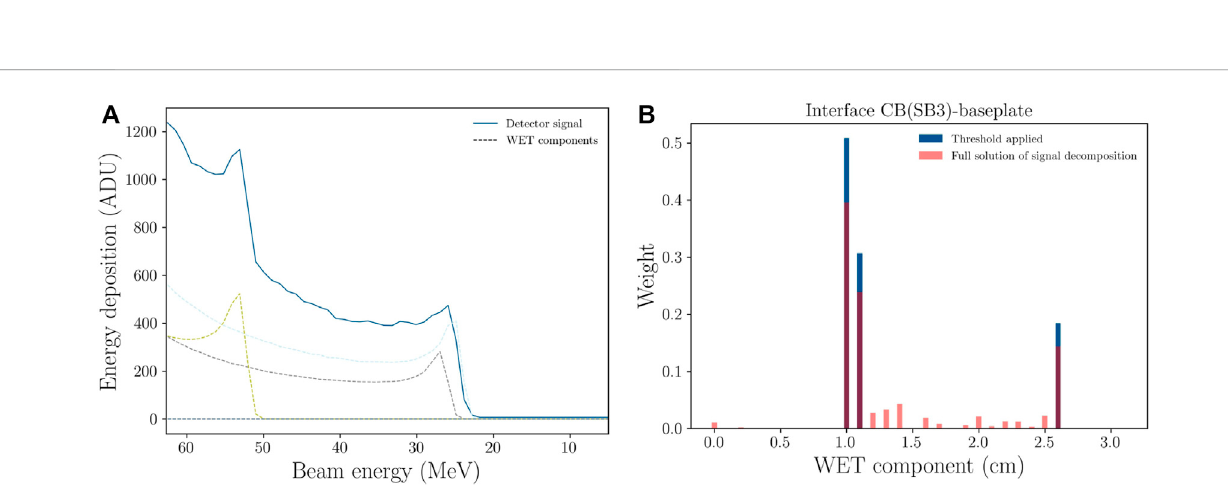
FIGURE 6 Example of the signal decomposition algorithm for a pixel in an interface region between the cortical bone (SB3) insert and the baseplate, leading to rangemixing. (A) Measureddetectorsignalinapixelwitharangemixing(solidline).TheWETcomponentsobtained via Braggpeakdecomposition(Figure6B) are indicated as dashed lines. (B) WET components found as solution corresponding to the signal in (A)